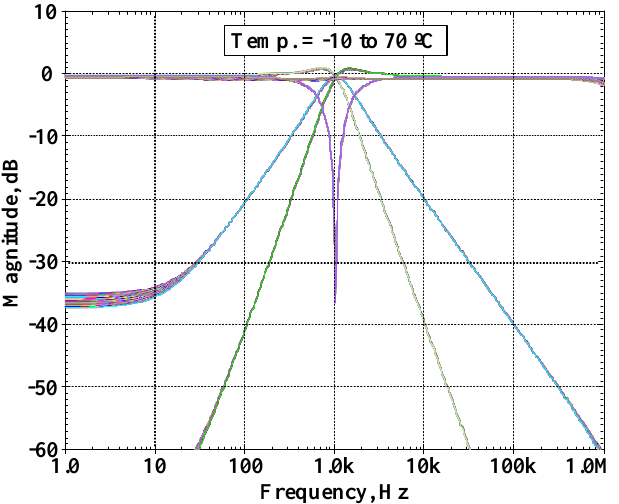
Figure 14. Figure 14. The simulated magnitude frequency responses of the universal filter with temperature variation.